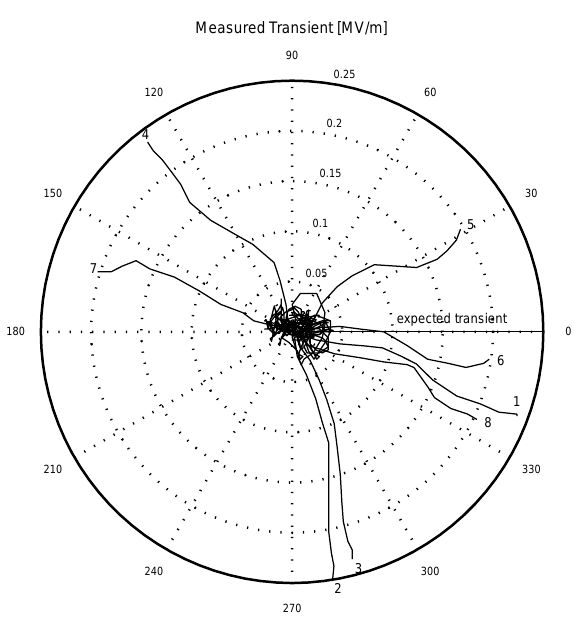
FIG. 28. Beam induced transients (cavity field vectors) ob- tained by measuring the cavity fields with and without beam pulses. The noise in the signals can be estimated from the er- ratic motion at the center of the plot. This region represents the first 50 m s of the measurement before the arrival of the beam pulse.